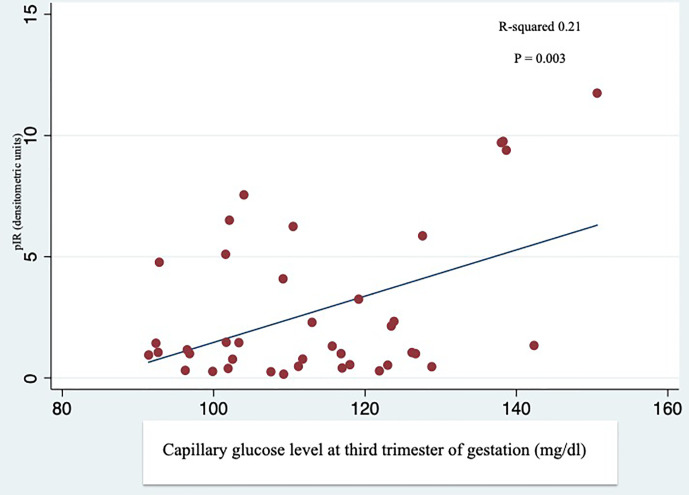
Linear regression analysis between phosphorylation of IR (pIR) and average capillary glucose levels during the third trimester. Self-monitoring of blood glucose performed by GDM and T1D patients during the third trimester of gestation was correlated with the IR phosphorylation in the placenta of GDM and T1D women.